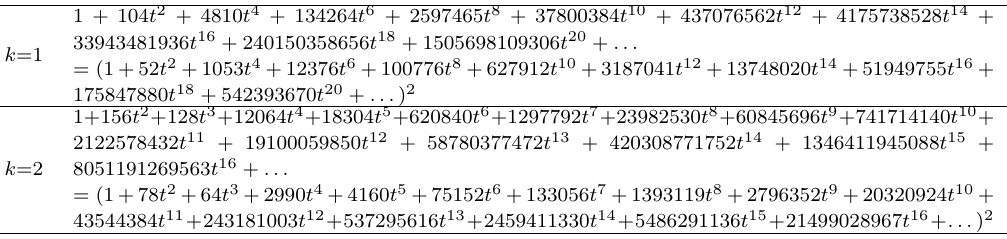
Table 12. Hilbert series results for (2.19). The first line displays the Coulomb branch Hilbert series for (2.19), while the second line displays the factorisation into a product. Each factor agrees with the known Hilbert series.